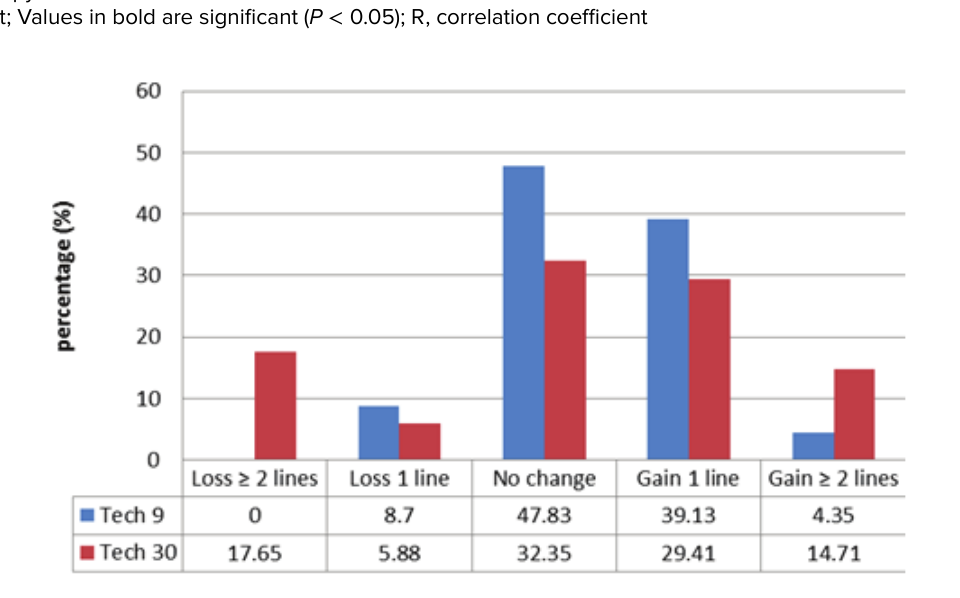
Figure 1. corrected distance visual acuity changes after 9 and 30 min corneal cross-linking